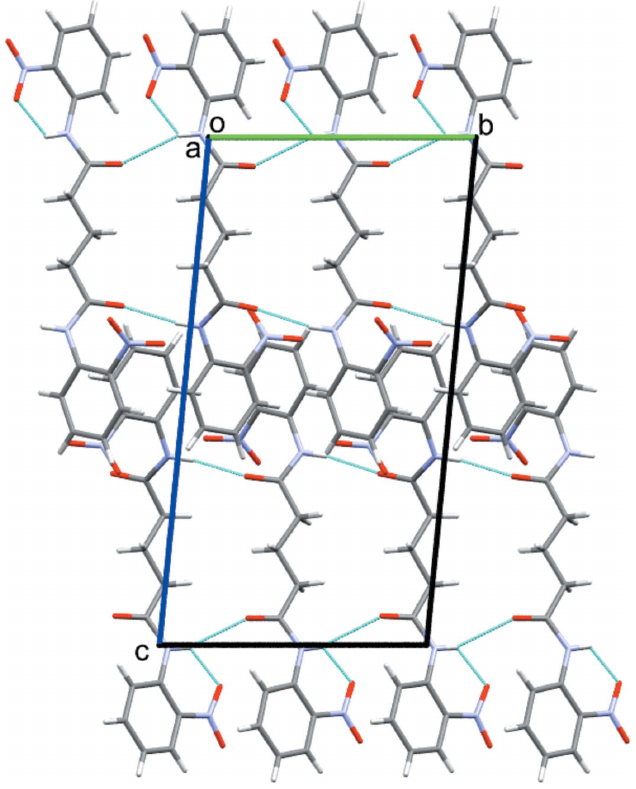
Figure 3 Molecular packing of (I) with hydrogen bonds shown as dashed lines.